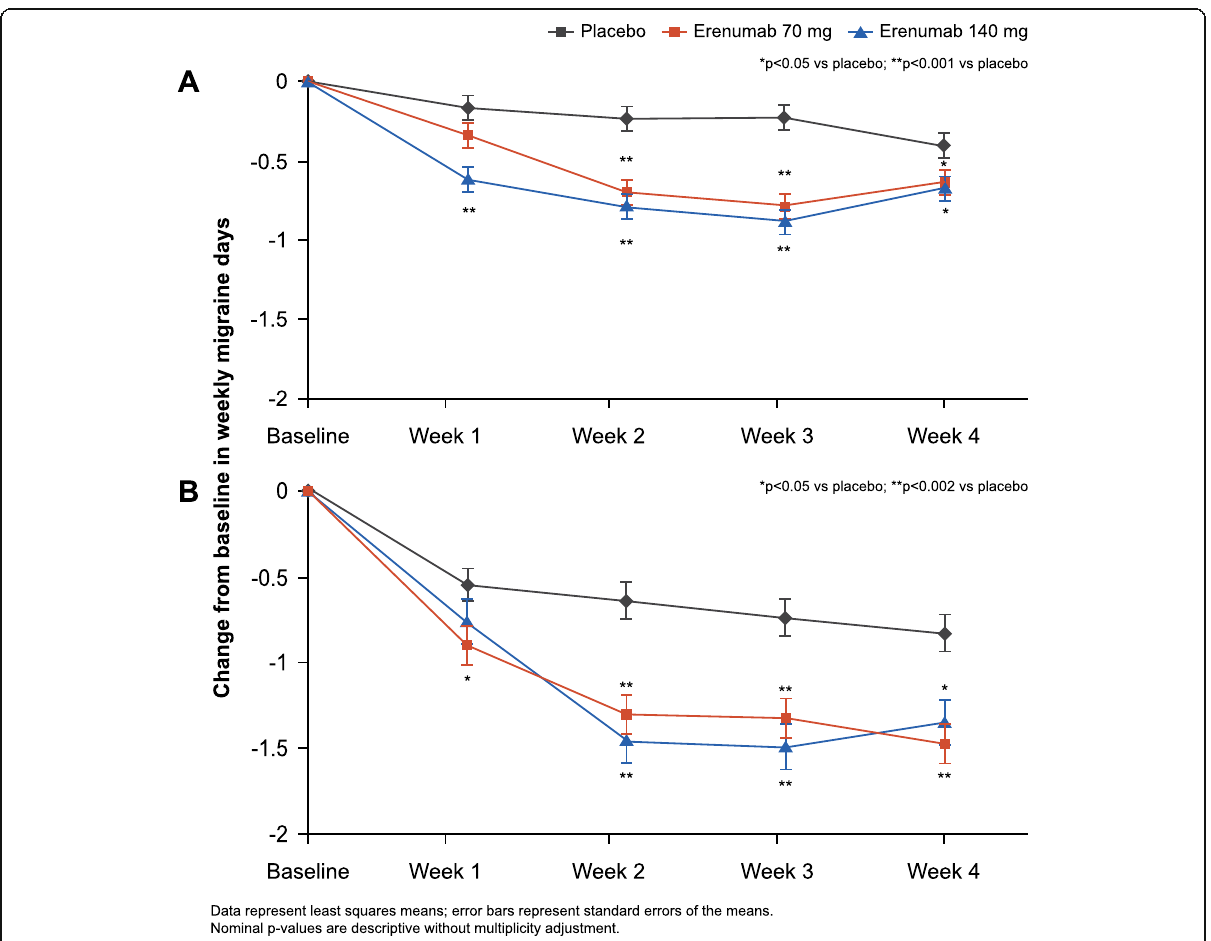
Fig. 2 Change from baseline in WMD during the first month of studies in episodic migraine ( a ) and chronic migraine ( b